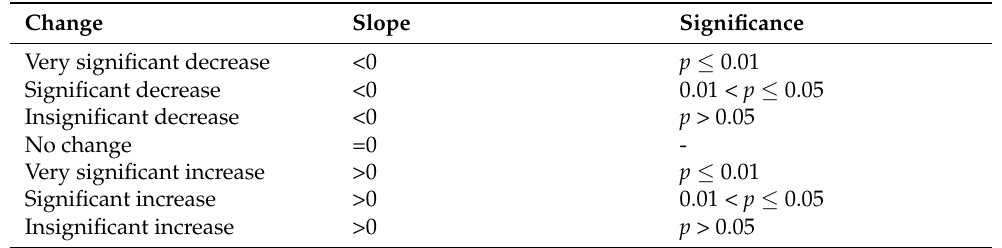
Table 2. Gradation table of vegetation coverage